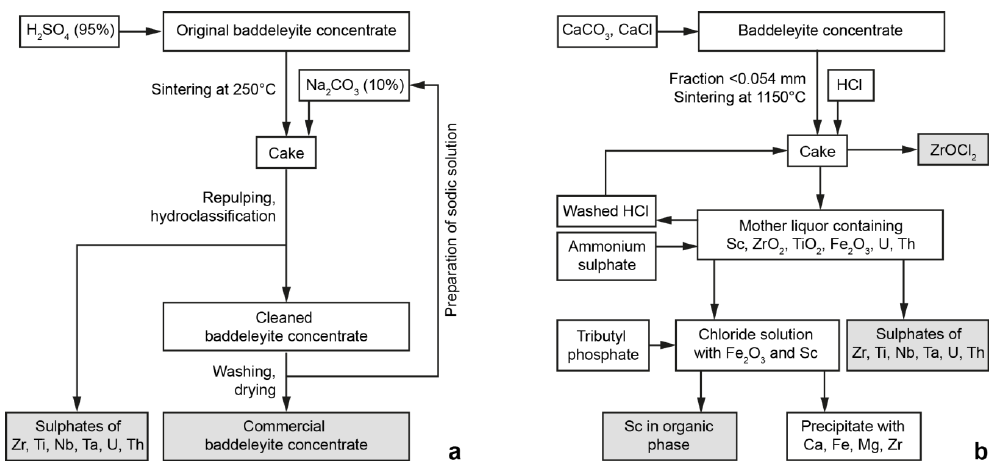
Figure 14. Process flow diagrams of the PSM-bearing baddeleyite concentrate acidic cleaning ( a , after [49]) and deep processing ( b , after [50,51]). Gray rectangles show final products.